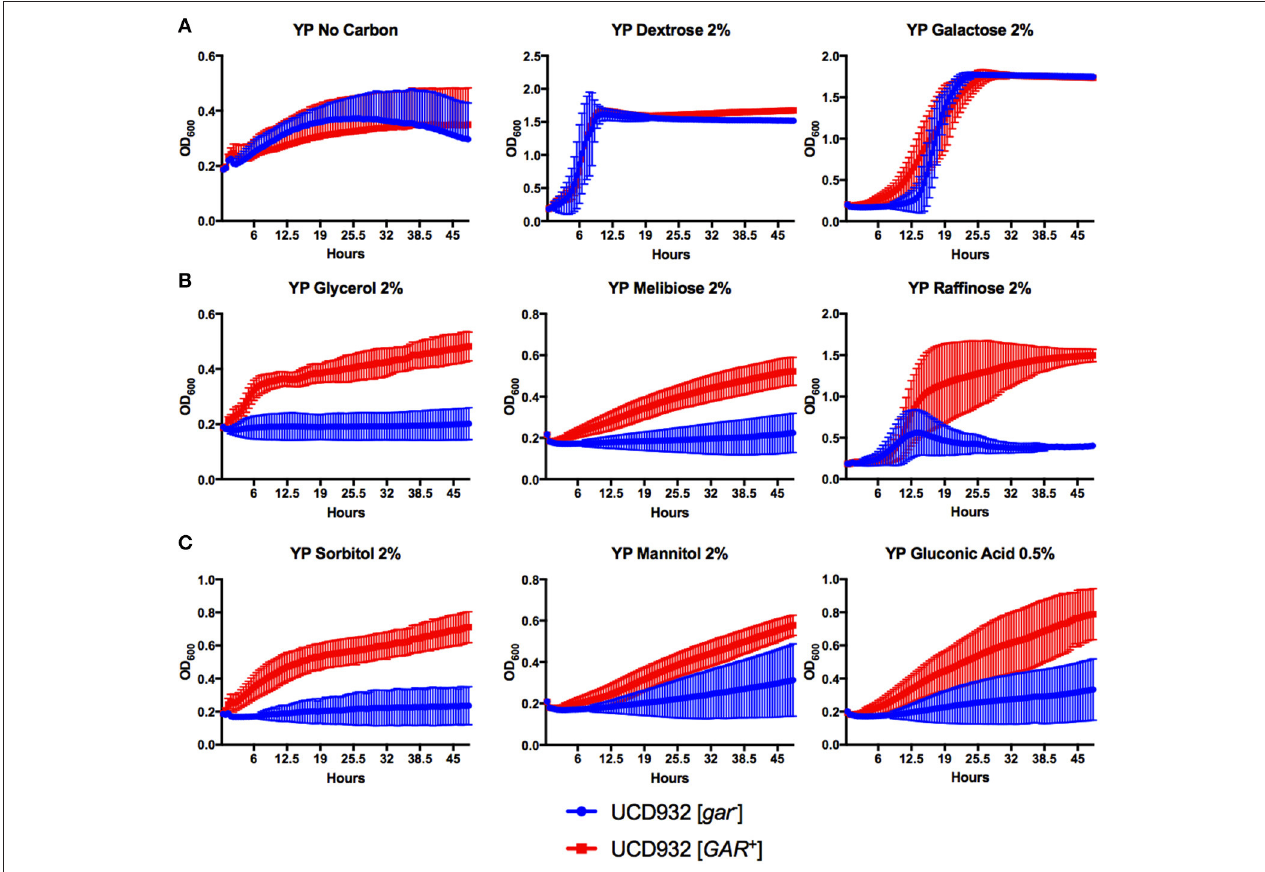
FIGURE 9 | Growth comparisons of UCD932 [ GAR + ] and UCD932 [ gar − ] strains on different substrates. No significant differences in the growth of UCD932 [ gar − ] vs. UCD932 [ GAR + ] occurred in the absence of added carbon source, or in the presence of glucose or galactose (A) . UCD932 [ GAR + ] displayed a distinct advantage over UCD932 [ gar − ] when growing on glucose repressible substrates glycerol, melibiose, and raffinose (B) . UCD932 [ GAR + ] displays better growth than UCD932 [ gar − ] on ecosystem substrates sorbitol, mannitol, and 0.5% gluconic acid (C)